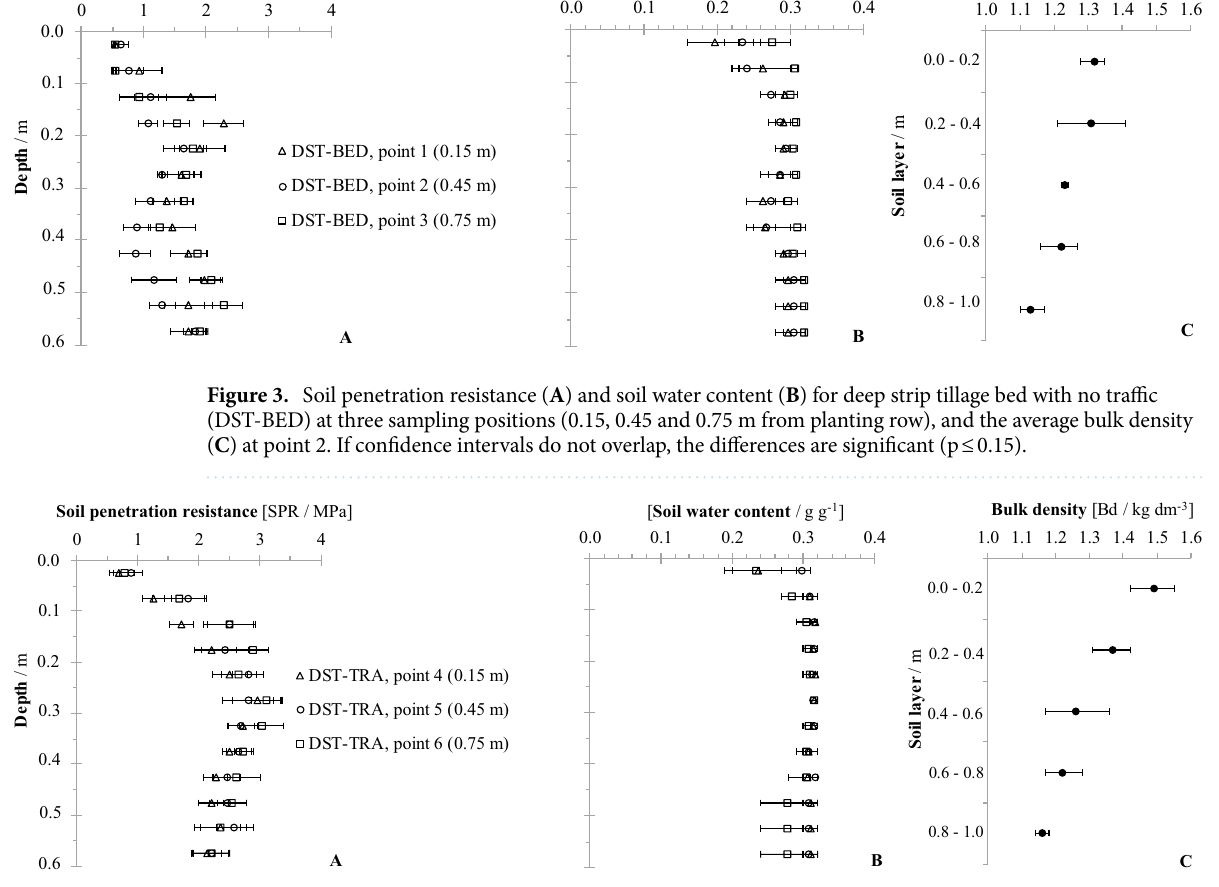
Figure 4. Soil penetration resistance ( A ) and soil water content ( B ) for the deep strip tillage traffic lane (DST- TRA) at the three sampling positions (0.15, 0.45, and 0.75 m from planting row)), and the average bulk density ( C ) at point 5. If confidence intervals do not overlap, the differences are significant (p ≤ 0.15).